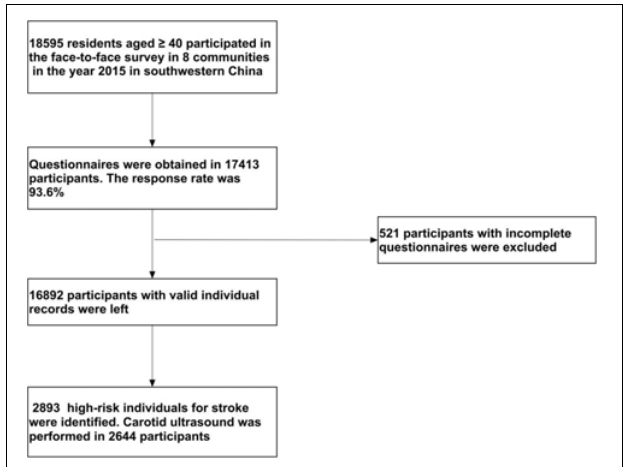
FIGURE 1 | Flow diagram of the data preparing and cleaning process in this